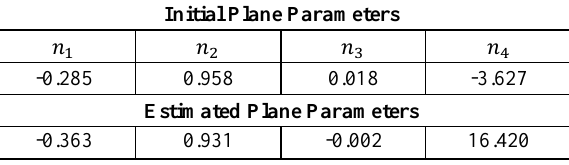
Table 4. Calibration result, plane parameters